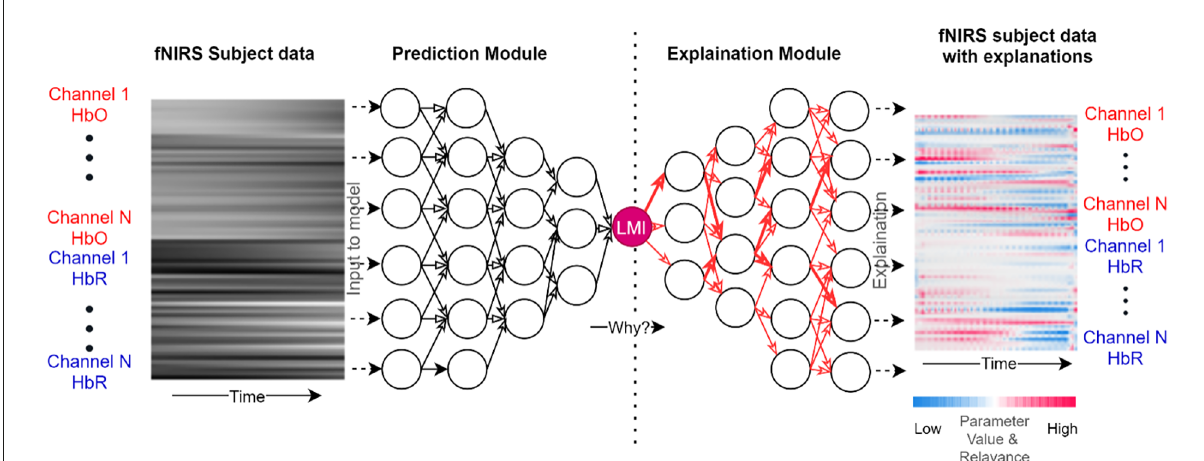
FIGURE1 Overview of xAI-fNIRS system. The Deep Learning Model in the prediction module uses the data from each participant in the form of frames as input. The model provides a prediction based on this data, such as 97% LMI (Left Motor Imagery/Left Active). The Deep Learning Predictions are then explained in terms of input variables such as channel 1 HbO, channel 2 HbR, and so on in the Explanation